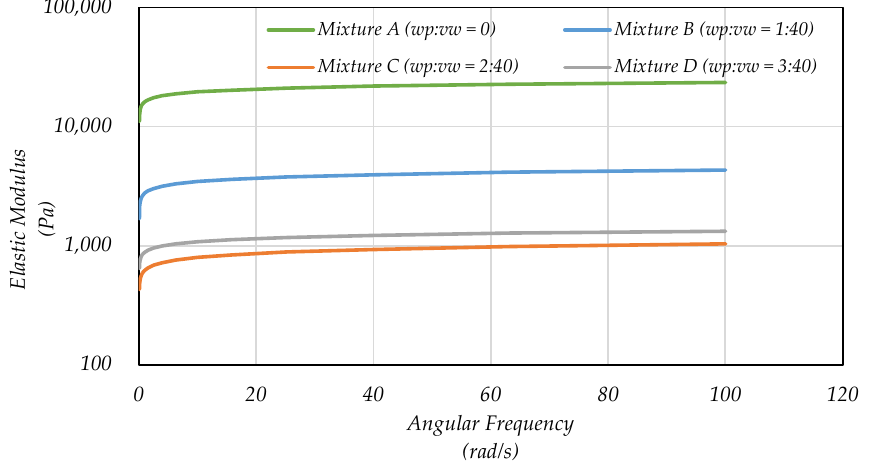
Figure 11. Relationships between elastic modulus (G′) and angular frequency for four biomass– fungi mixtures.